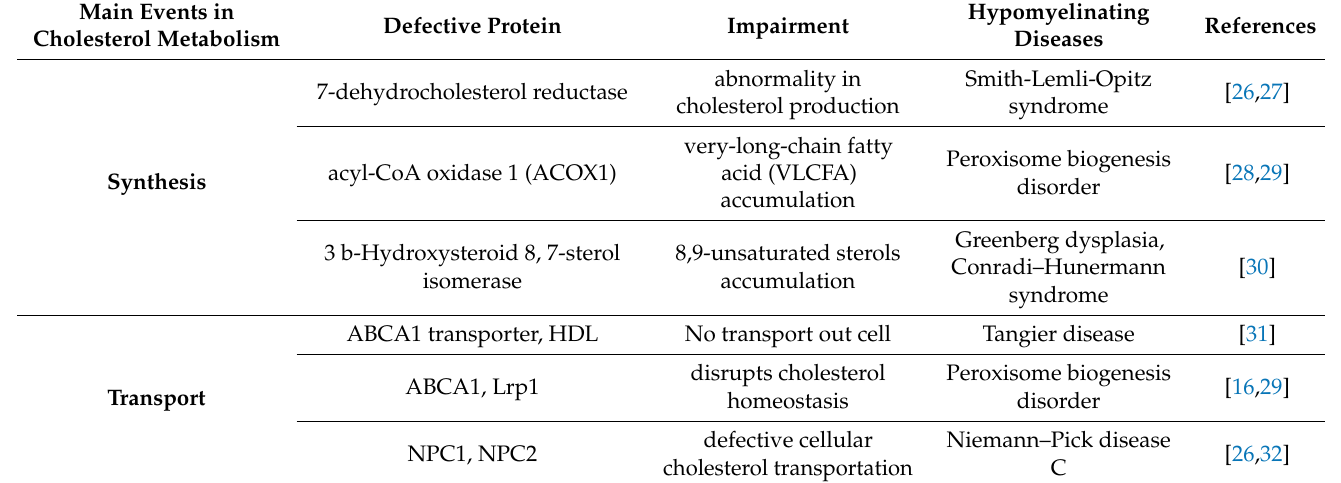
Table 1. Hypomyelinating diseases connected to cholesterol metabolic processes